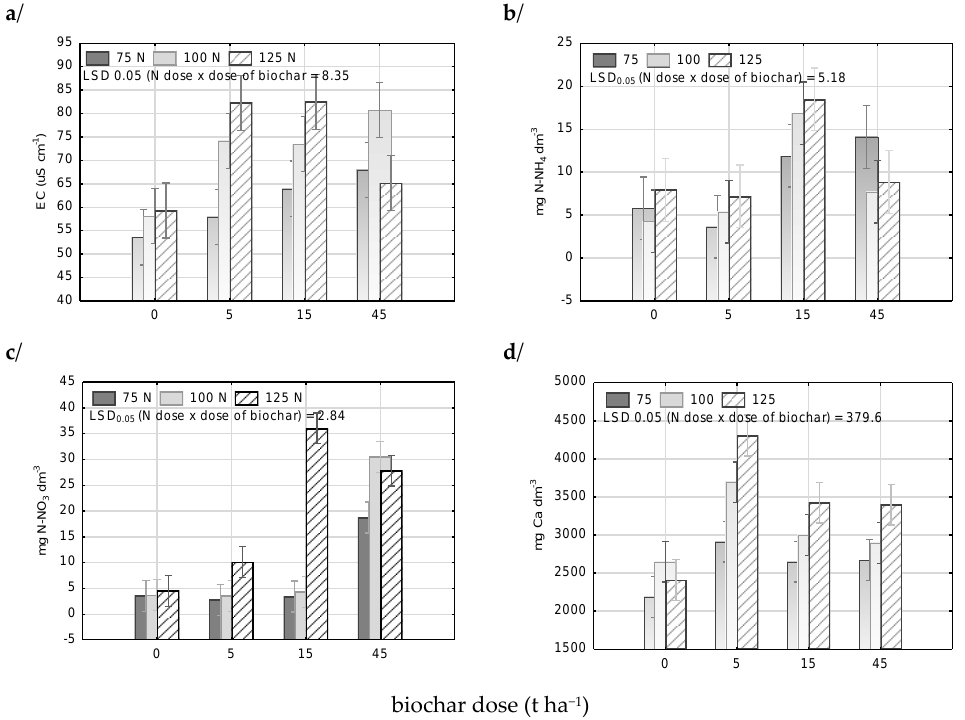
Figure 4. Soil reaction (pH), salt concentration (EC), and the content of mineral nitrogen and calcium (mg dm − 3 ) in the soil depending on the applied dose of biochar and fertilizer nitrogen (average from 2017 – 2019).